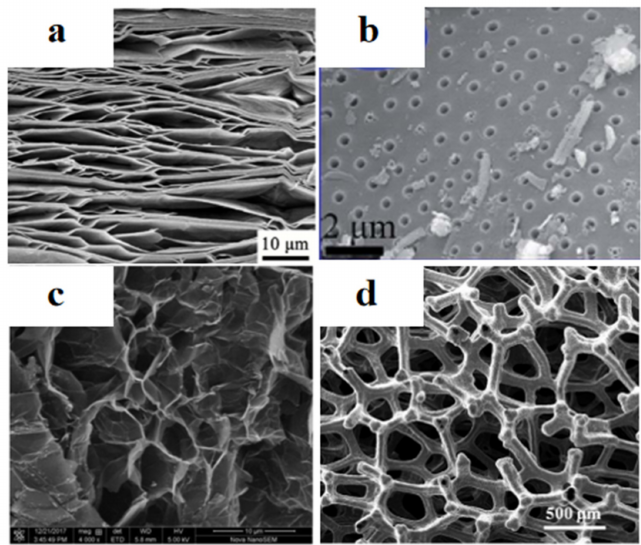
Figure 9. SEM images of ( a ) EVM [147] (Copyright (2021) with permission from Elsevier B.V.), ( b ) diatomite [133] (Copyright (2015) with permission from Royal Society of Chemistry), ( c ) EG [43] (Copyright (2018) with permission from Elsevier Ltd.), ( d ) 3D porous diamond foam [137] (Copyright (2018) with permission from Elsevier